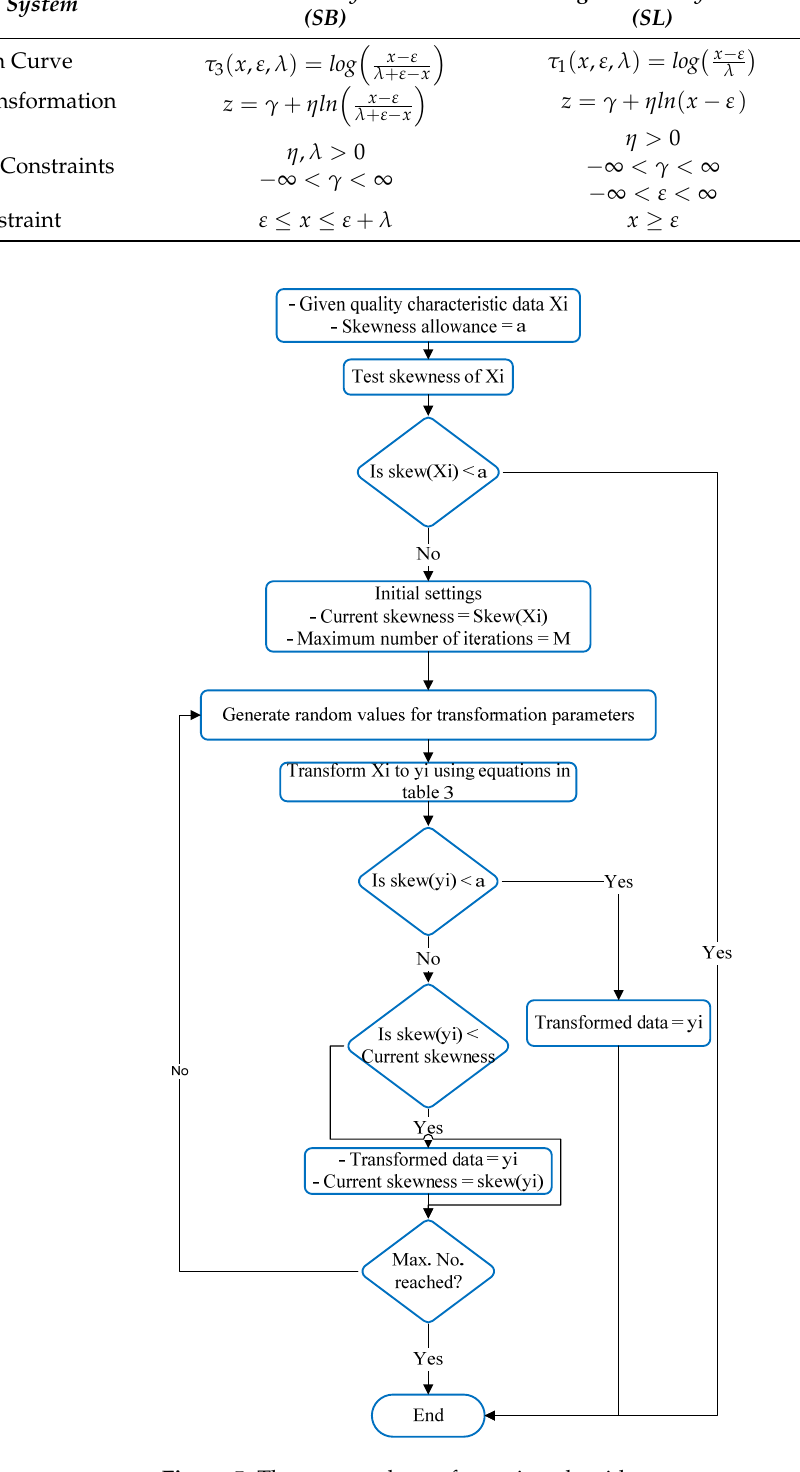
Figure 5. The proposed transformation algorithm.